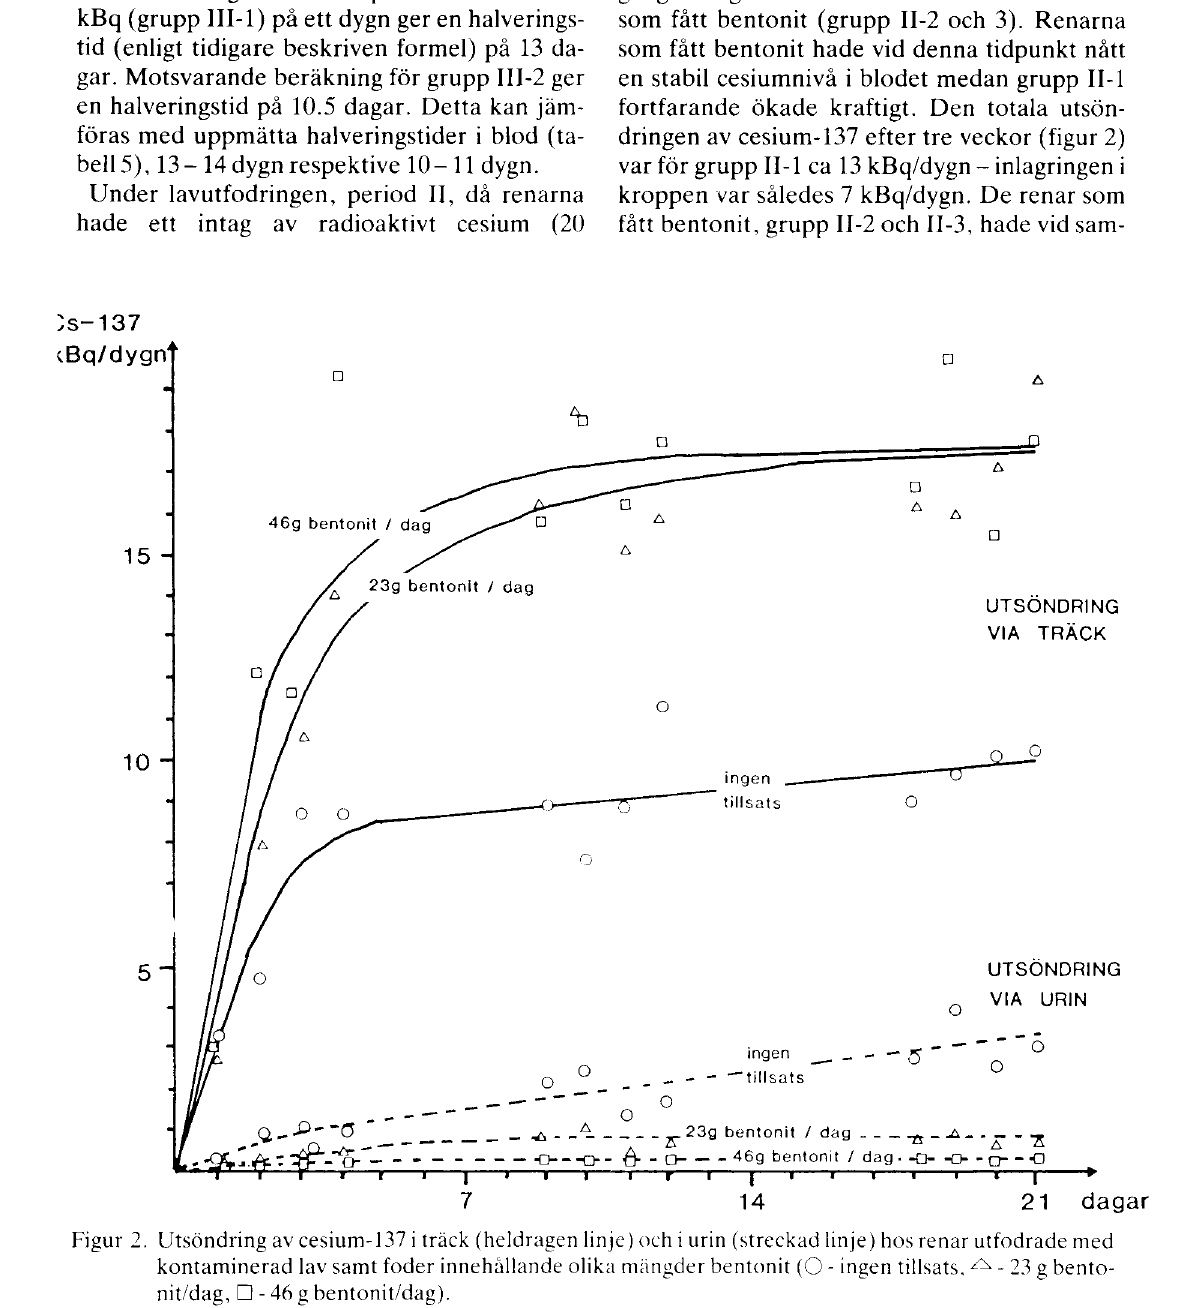
Figur 2. Utsondring av cesium-137 i track (heldragen linje) och i urin (streckad linje) hos renar utfodrade med kontaminerad lav samt foder innehållande olika mångder bentonit (O - ingen tillsats, ^ - 23 g bento nit/dag, • - 46 g bentonit/dag). Figure 2. Exretion of Cs-137 in faeces (continuous line) and urine (dotted line) in reindeer fed 500 g lichens (D. M.), containing 40 kBq Cs-137/kg D. M. , per day in combination with pellets and no supplements (O), 23 g bentonite/dav (^) or 46 g bentonite'dax